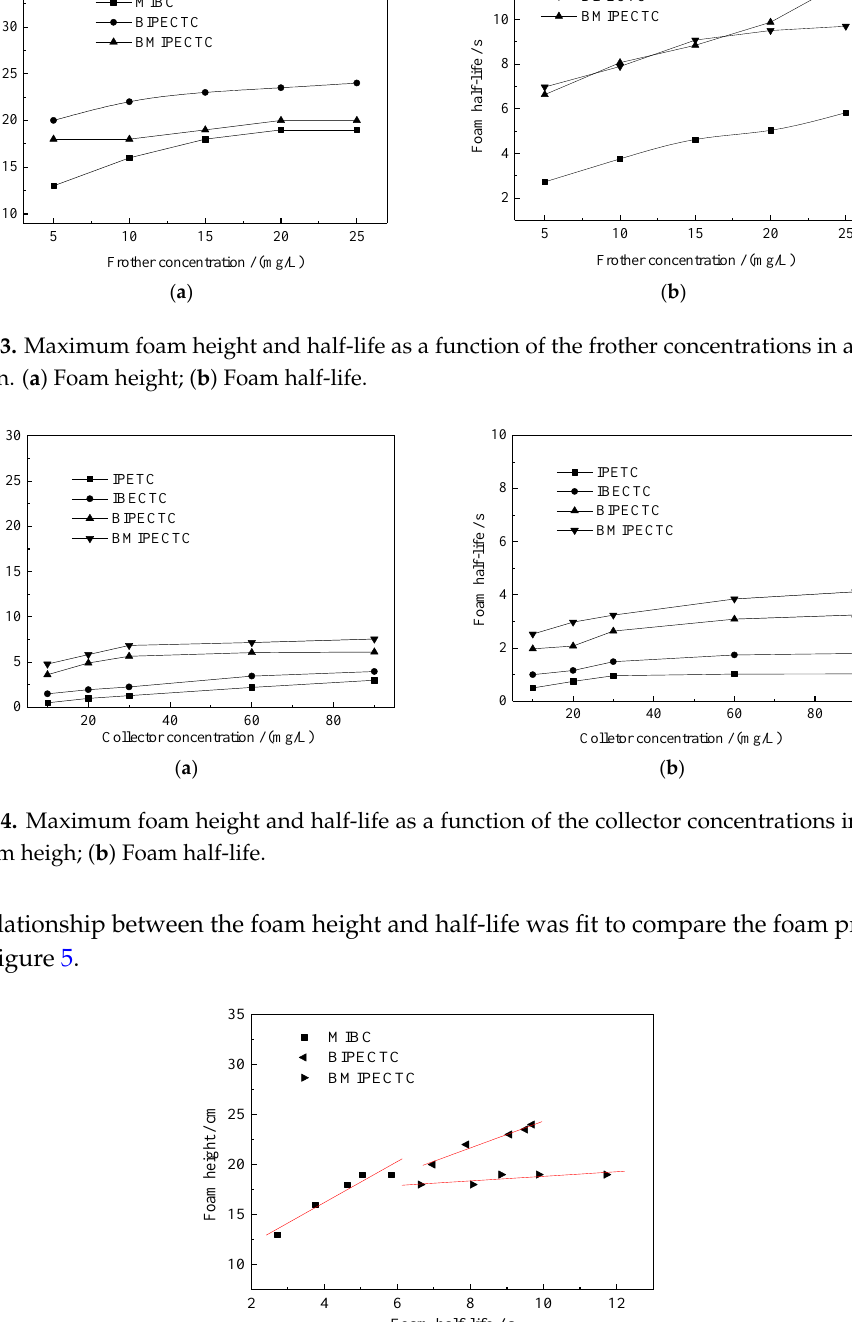
Figure 5. Relationship between the foam height and half-life.